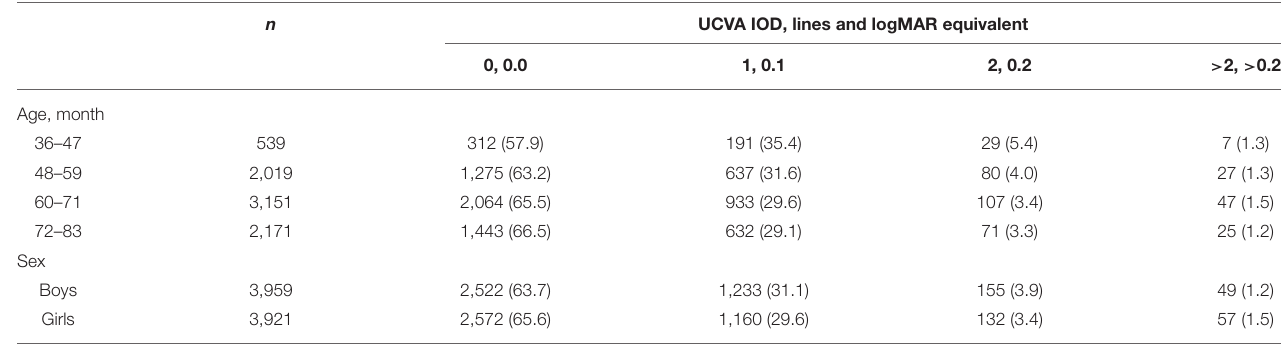
TABLE 4 | Distribution of UCVA interocular difference (IOD) in the reference